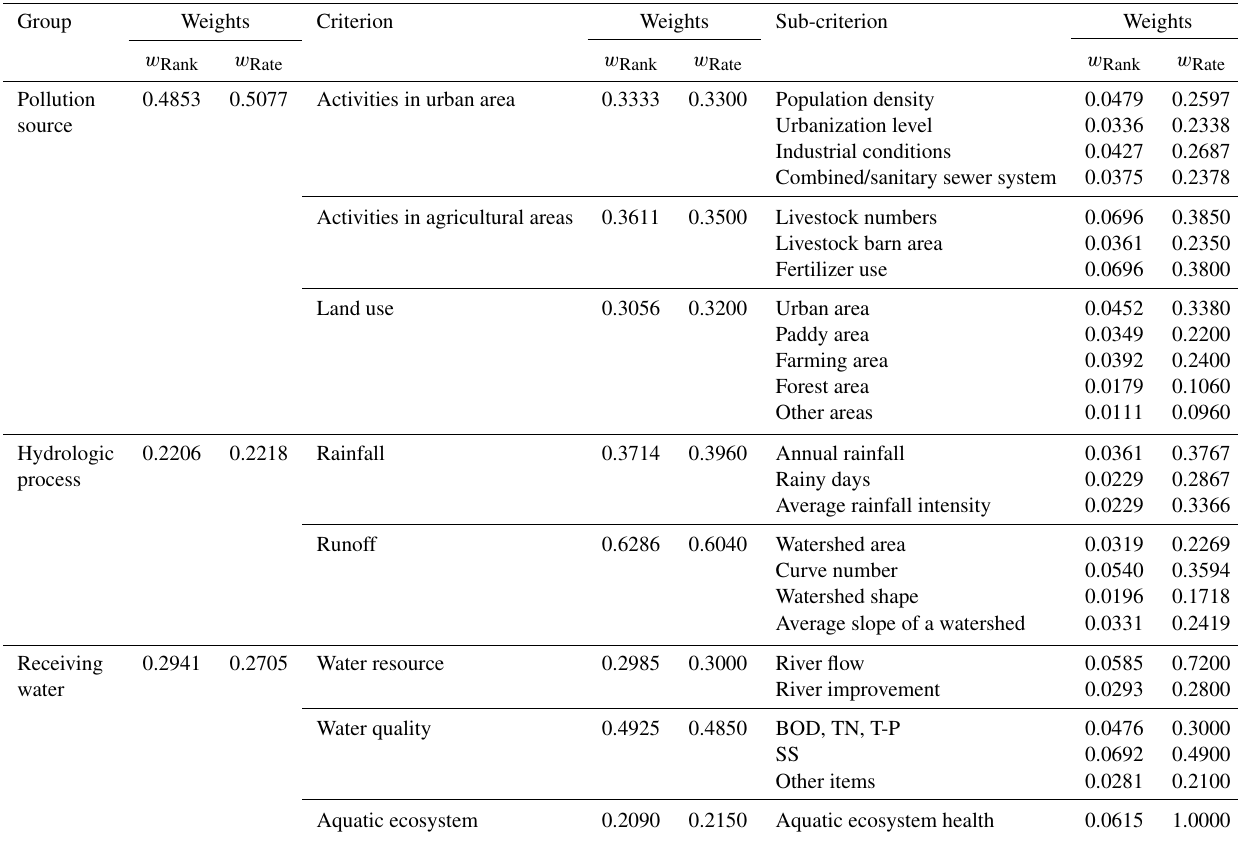
Table 3. Determination of the weights by the Delphi survey. Group